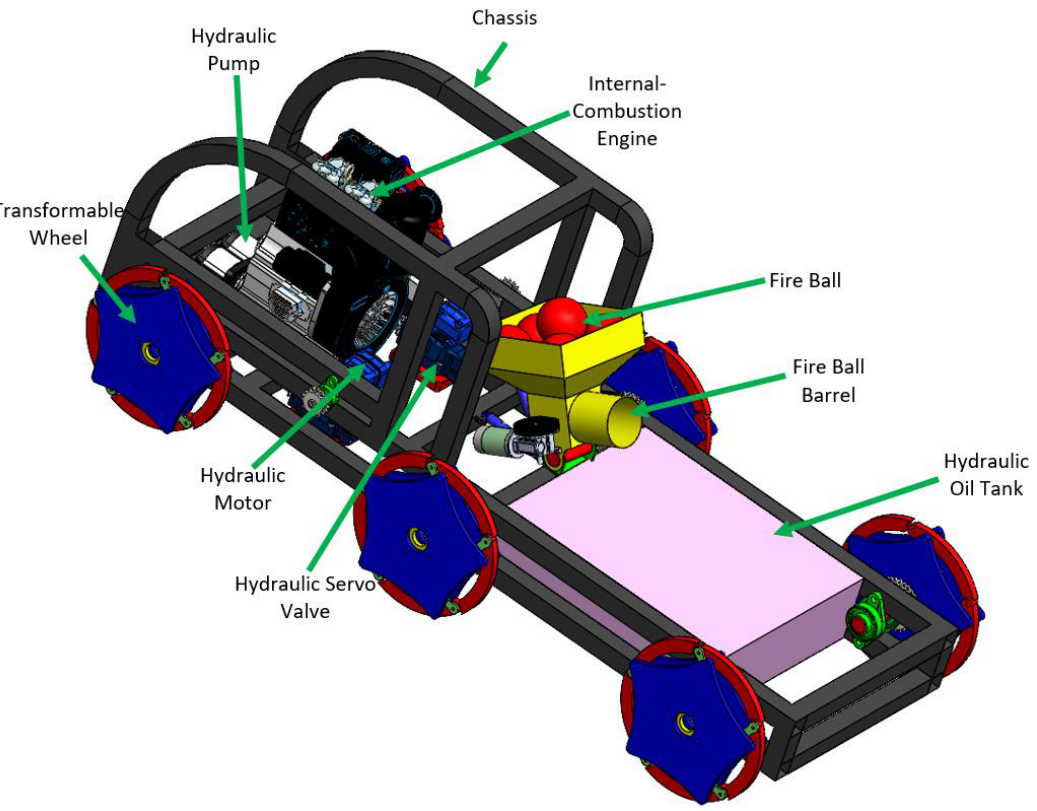
Figure 2. CAD views of designed Fire Fighting Robot with Fire Extinguishing Ball Shooting System.